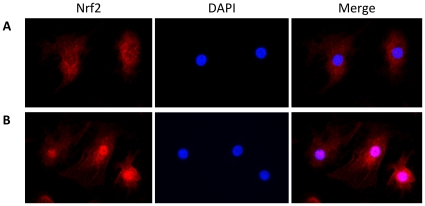
CSE induces nuclear localization of Nrf2 in ATI-like cells as detected by immunocytofluorescence.A - Cytoplasmic localization of Nrf2 in control cells (red stain); B - Nuclear translocation of Nrf2 after 4 h treatment with 5% CSE. Representative data each from one of three experiments are shown.